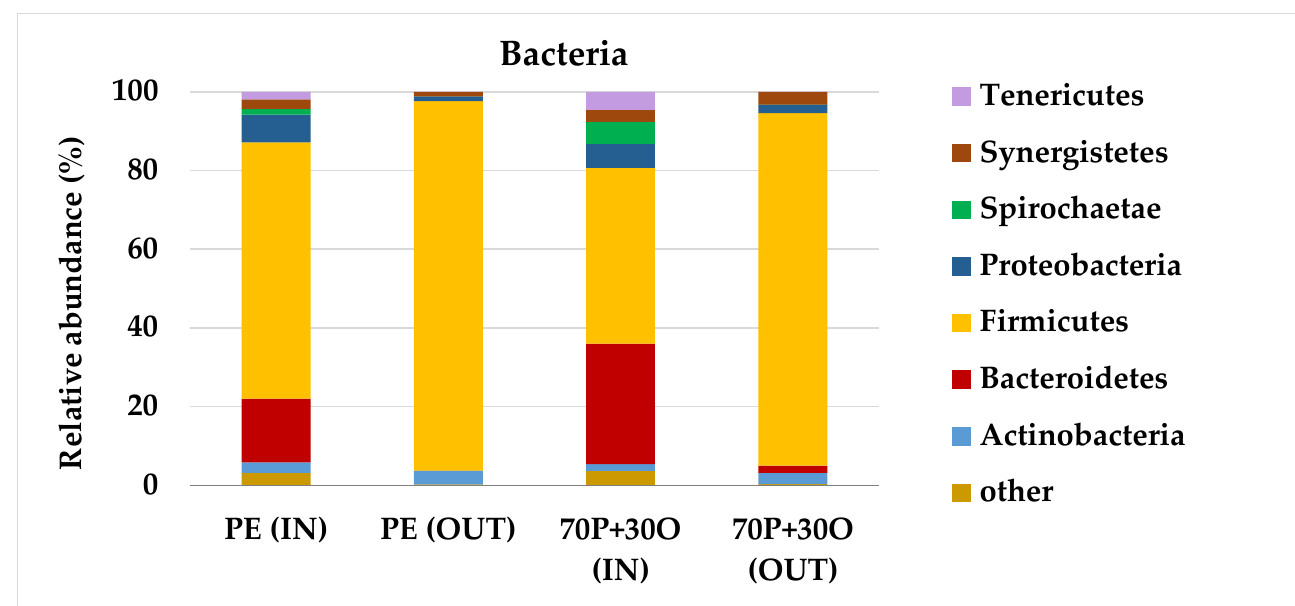
Figure 3. Relative abundance of Bacteria phyla. Other phyla were not considered in this discussion due to their low presence (0.01–1.2%): Armatimonadetes; Atribacteria; BRC1; Chlamydiae; Chlorobi; Chloroflexi; Cloacimonetes; Cyanobacte-